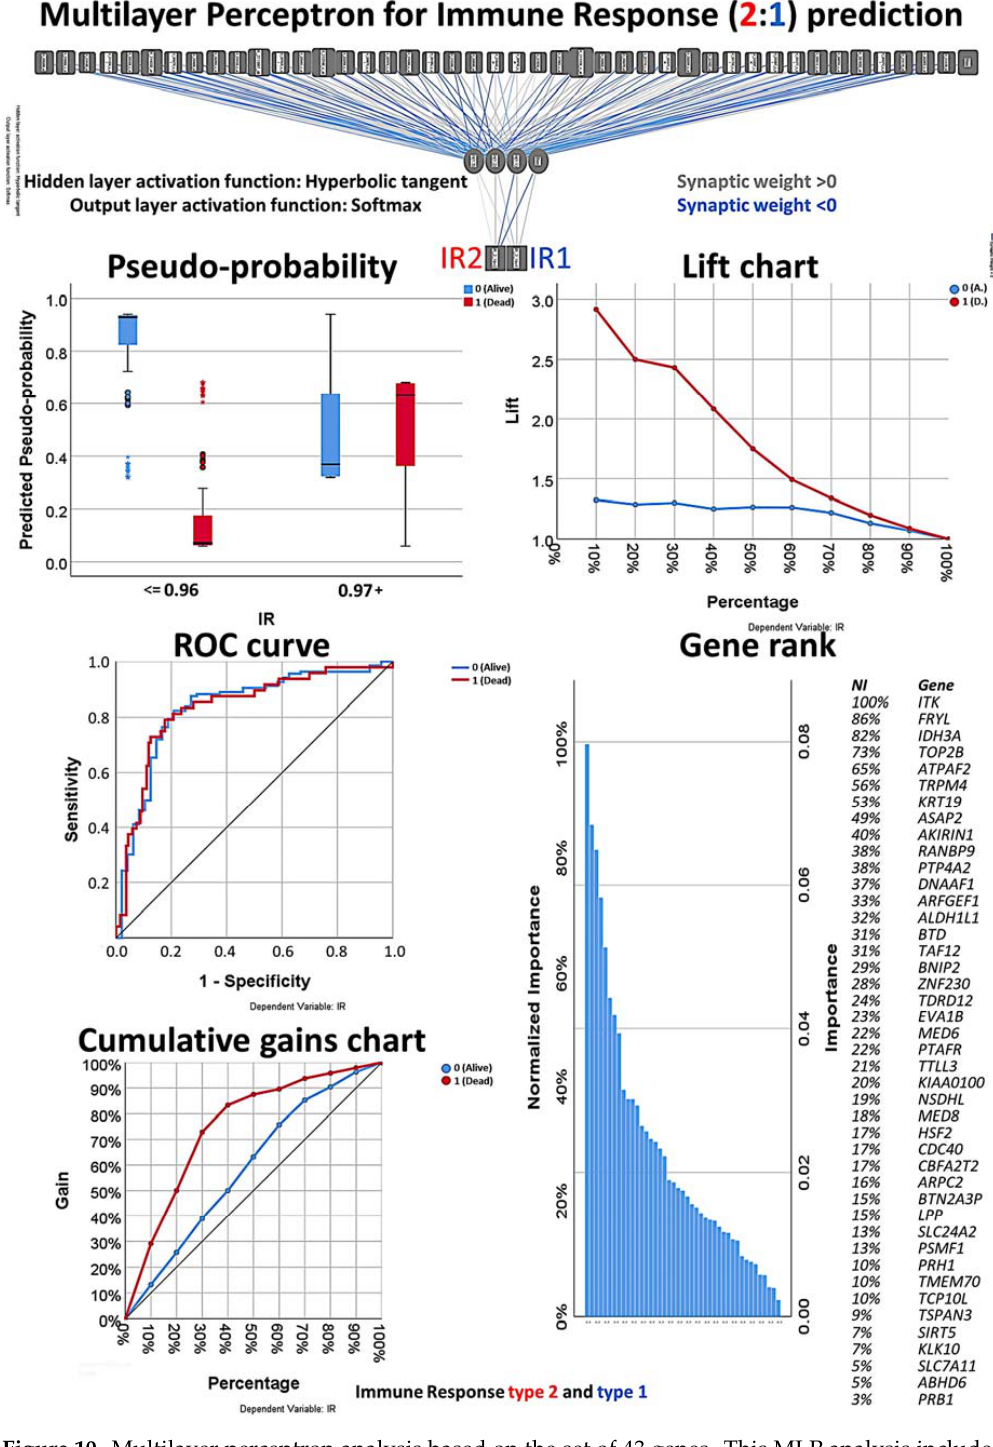
Figure 10. Multilayer perceptron analysis based on the set of 43 genes. This MLP analysis includes only the final set of 43 genes as input variables and predicts the immune response of the patients based on the immune response 2:1 ratio. The quality of the neural network analysis can be confirmed with the ROC curve, and the rank of the genes is shown according to their normalized importance for